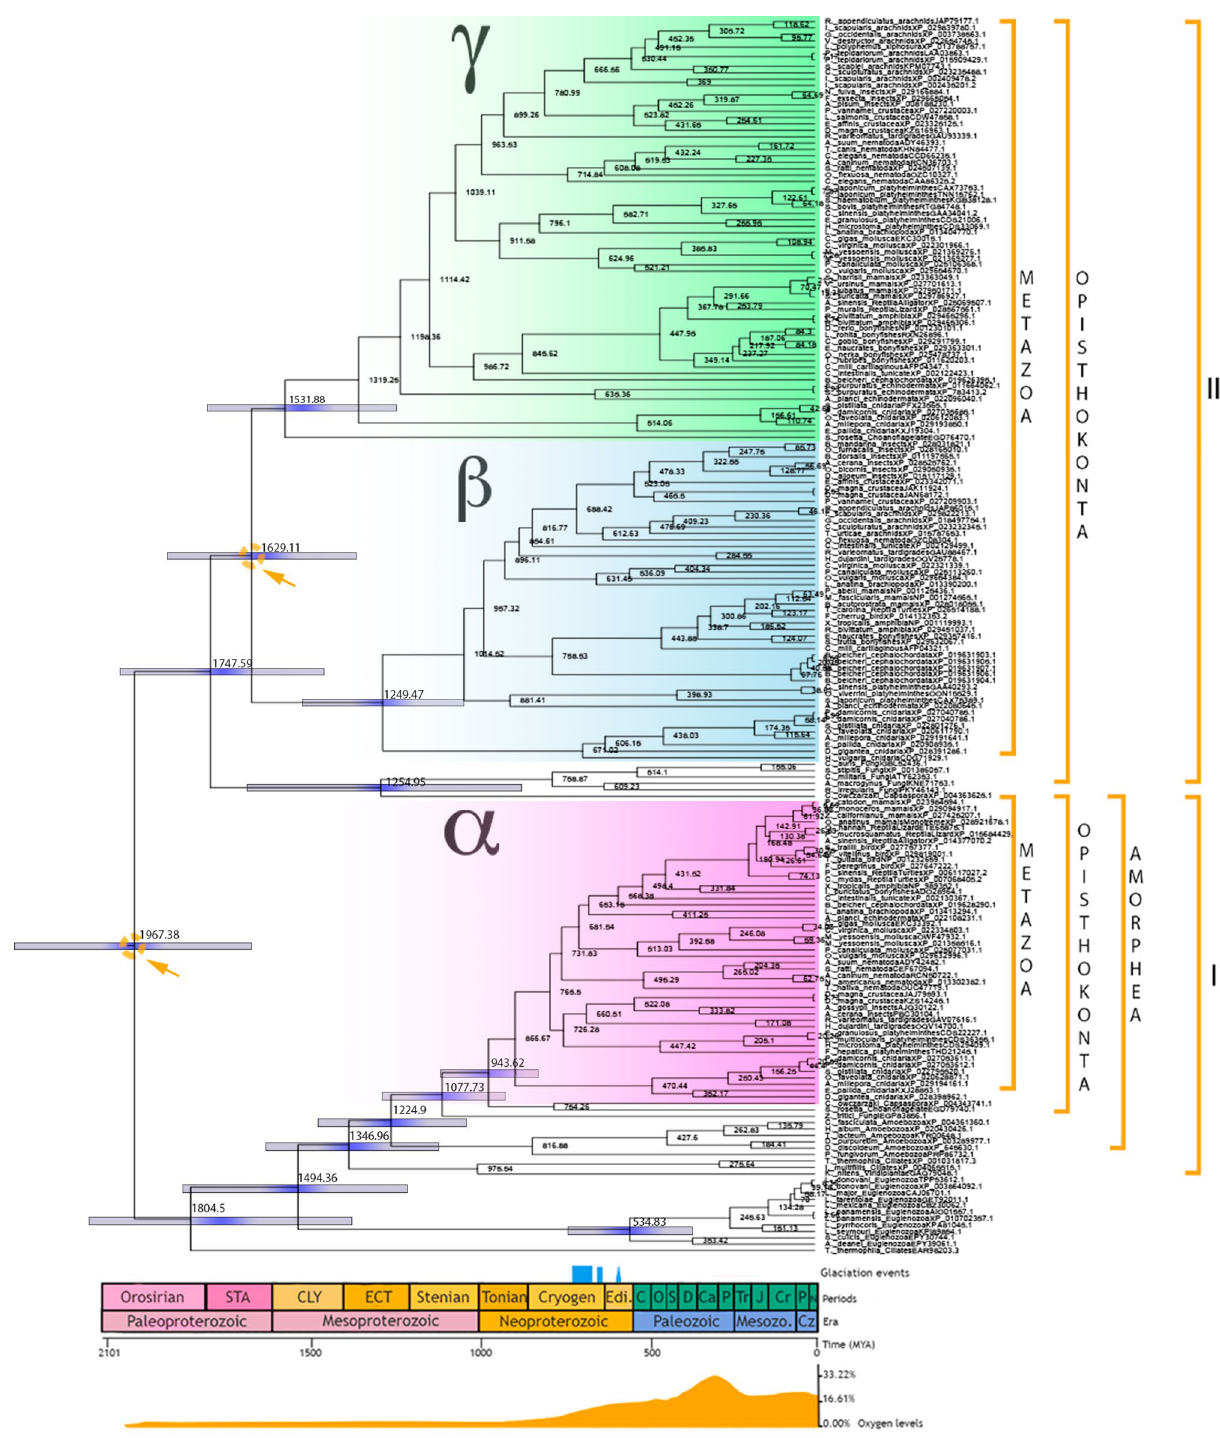
Figure 2. Timetree of NAD-isocitrate dehydrogenases. Clades I and II contain eukaryotic catalytic and regulatory subunits, respectively. The pink clade refers to metazoan catalytic subunit α, the blue clade refers to metazoan regulatory subunit β, and the green clade is the metazoan regulatory subunit γ. Node ages are plotted and node bars are displaying 95% HDP. STA, Statherian; CLY, Calymmian; ECT, Ectasian; Ediac, Ediacaran; C, Cambrian; O, Ordovician; S, Silurian; D, Devonian; Carb, Carboniferous, P, Permian; Tr, Triassic; J, Jurassic; K, Cretaceous; Pg, Paleogene; Ng, Neogene; Cz, Cenozoic; Ma, Million years ago. Glaciation events and atmospheric oxygen level estimates are indicated. The number after the taxon name indicates the genetic identifier (GenBank) for each